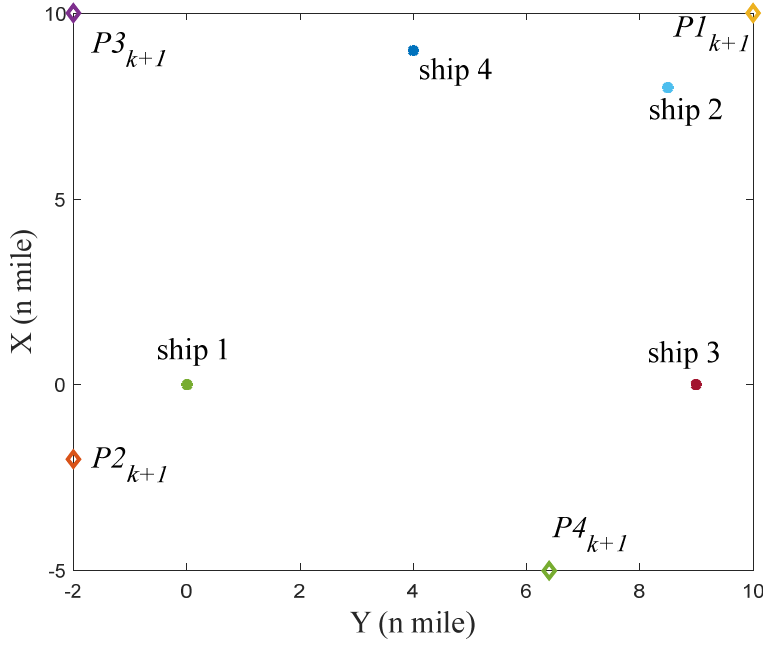
Figure 24. The initial situation of four ships in scenario 3 under environment disturbance.